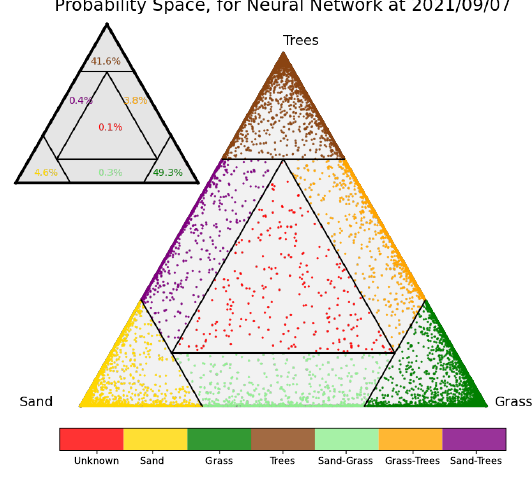
Figure 4. Scatter plot of pixel probabilities as output by the Neural Network method. The small triangle at the top left shows the percentage of pixels for each of the seven sub-polygons of the big triangle. The 4-gons along the edges of the big triangle are interpreted as mixed classes like